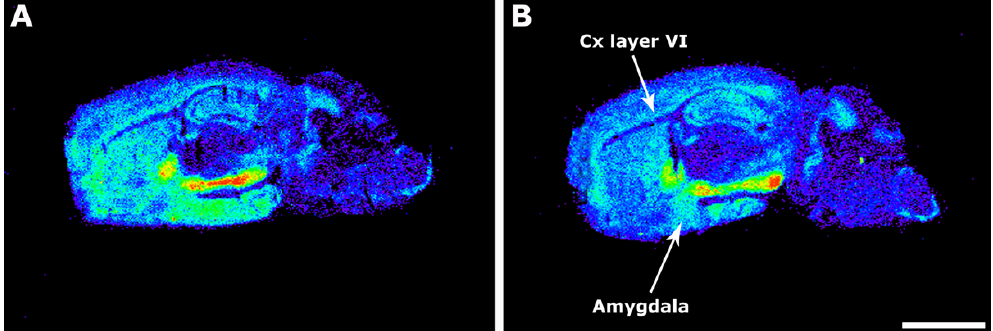
Figure 1. Representative autoradiograms of WT ( A ) and 3xTg-AD ( B ) mice in sagittal sections that show [ 35 S]GTP γ S binding stimulated by WIN55,212-2 (10 − 5 M). Note the decrease of the CB 1 –mediated activity at layer VI of the cortex (Cx Layer VI) and at the medial amygdala. Scale bar = 3 mm.